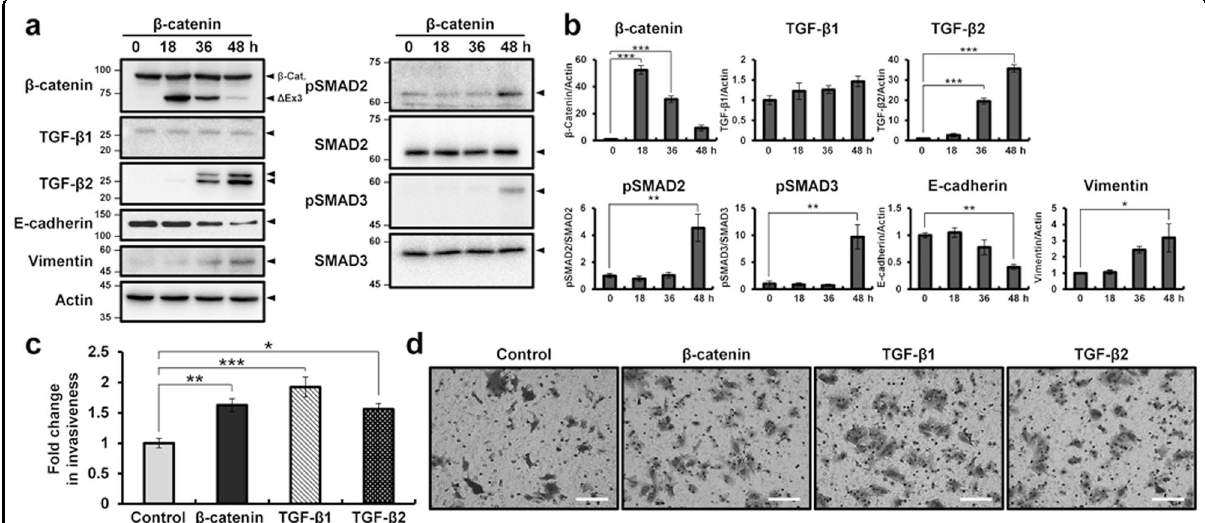
Fig. 5 Increased TGF- β 2 by β -catenin activation leads to EMT in adenomyosis development. a Western blot analysis of β -catenin, TGF- β 2, E- cadherin, and vimentin in Ishikawa cells transfected with exon 3-deleted β -catenin vector for 0, 18, 36, and 48 h. Actin was used as a sample loading control. b Quanti fi cation of western blot results in Ishikawa cells transfected with exon 3-deleted β -catenin vector for 0, 18, 36, and 48 h ( n = 3). c Quanti fi cation of invasion through the Matrigel and transwell membrane of Ishikawa cells transfected with control or exon 3-deleted β -catenin vector and treated with TGF- β 1 or TGF- β 2 ( n = 5). d Representative results of transwell invasion assays of control or exon 3-deleted β -catenin vector- transfected and TGF- β 1- or TGF- β 2-treated Ishikawa cells. The results represent the mean ± SEM. * p < 0.05, ** p < 0.01, and *** p < 0.001. Scale bars represent 100 μ